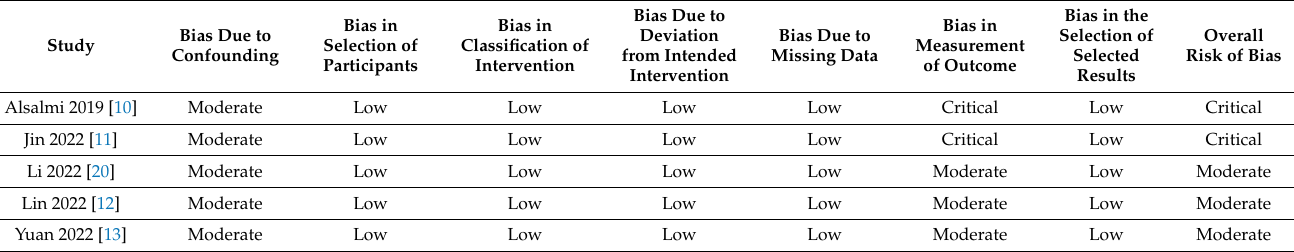
Table 2. Quality assessment of included studies.